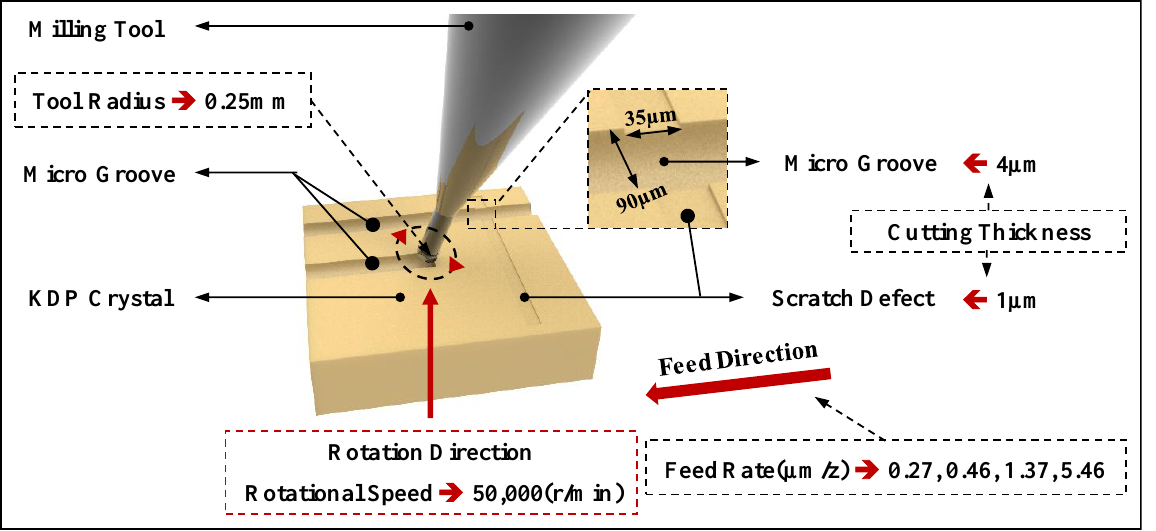
Figure 3. The schematic of the micro-milling repair process for flawed KDP crystal surfaces. Table 5. Cutting parameters applied in the micro-milling repair process of KDP crystals.